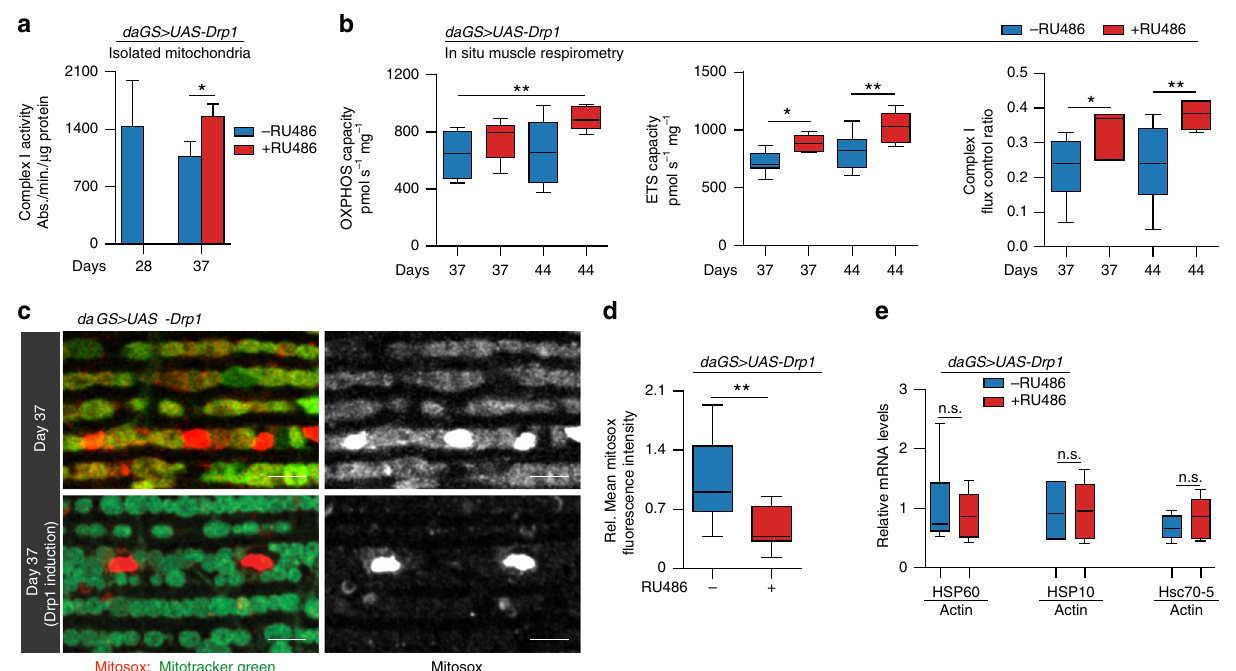
Fig. 4 Midlife Drp1 induction improves mitochondrial respiratory function. a , b Quanti fi cation of markers of mitochondrial activity in 28, 37, and 44 day old daGS > UAS-Drp1 females with or without RU486-mediated transgene induction since midlife (day 30 onwards). Complex I activity measurements a in isolated mitochondrial pellet from 28 to 37 day old adult females. n = 5 biological replicates with fi ve fl ies per replicate; ** p < 0.01; two-tailed unpaired t -test. b In situ respirometry of permeabilized muscle bundles from 37 to 44 day old adult females to assess the capacity for oxidative phosphorylation (OXPHOS) and Electron Transport System (ETS) fl ux, and the fl ux control ratio of Complex I by rotenone inhibition. n = 6 – 8 biological replicates with 2 fl ies per replicate; ** p < 0.01 and * p < 0.05; one-way ANOVA/Bonferroni ’ s multiple comparisons test. c , d Staining of indirect fl ight muscles c from 37 day old daGS > UAS-Drp1 females with or without RU486-mediated transgene induction from day 30 to day 37, showing mitochondria ( green channel , Mitotracker green staining) and levels of superoxide radicals ( red channel , staining with MitoSOX reagent). Scale bar is 5 µ m. Quanti fi cation of free superoxide radicals d ; n = 11 – 16 biological replicates; ** p < 0.01; two-tailed unpaired t -test. e qPCR analyses of Hsp60 , Hsp10 , and mtHsp70 ( Hsc70-5 ) on day 37 in daGS > UAS-Drp1 females with or without RU486-mediated transgene induction from day 30 to day 37. n = 5 biological replicates with 3 fl ies per replicate; p > 0.05 and is non-signi fi cant (n.s.); two-tailed unpaired t -test. Bars a depict mean ± s.d. Boxplots b , d and e display the fi rst and third quartile, with the horizontal bar at the median and whiskers showing the most extreme data point, which is no more than 1.5 times the interquartile range from the box. RU486 was provided in the media at a concentration of 25 μ